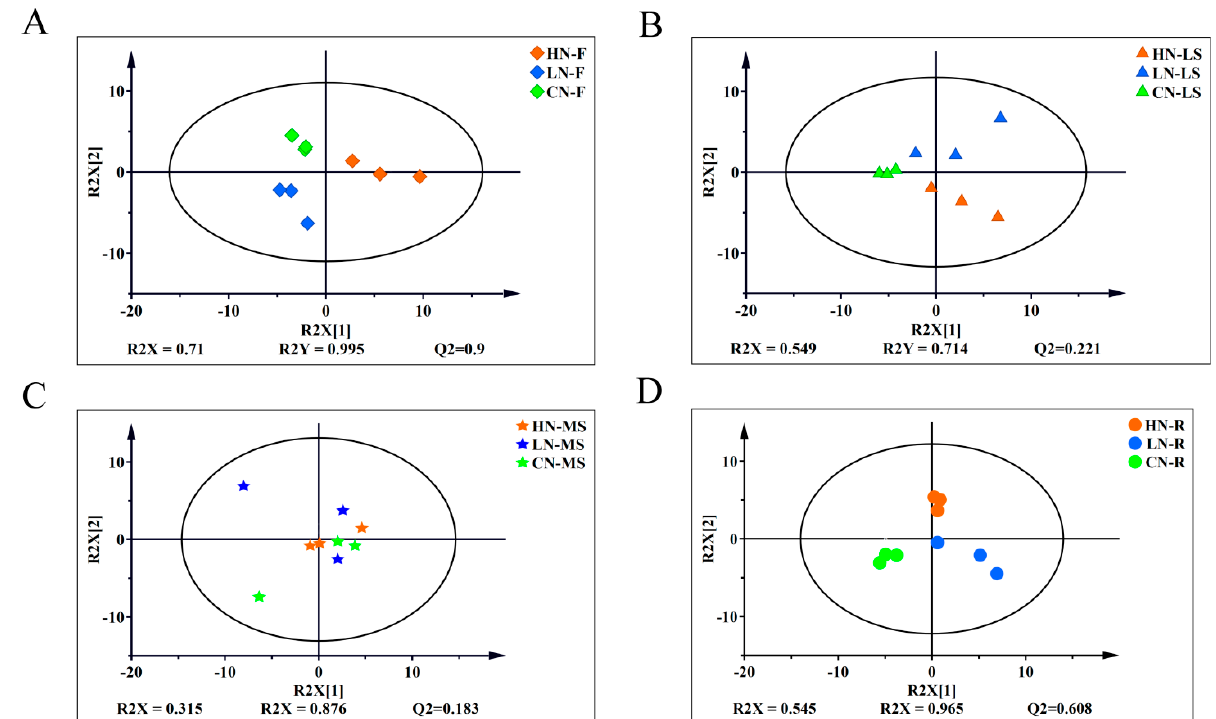
Figure 4. PLS − DA score plot classifying the CN, LN and HN groups from metabolites of Bupleurum in flowers, lateral shoots, main shoots and roots ( A – D ), respectively. Different markers and colors represent different meanings: ● represents roots (R), ◆ represents flowers (F), ▲ represents lateral shoots (LS), ★ represents main shoots (MS); red, green and blue represent high nitrogen (HN) groups, low nitrogen (LN) and control nitrogen (CN), respectively.